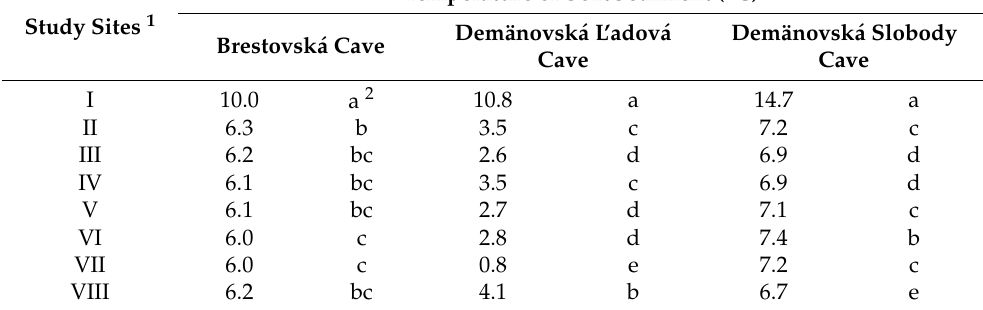
Table 1. The average of temperature of soil/sediment ( n = 9) measured in the studied Slovak caves. 1 See Figure 1 for locations (I—outside underground facilities, II–VIII—inside underground facilities). 2 Letters refer to the Tukey’s HSD test ( α ≤ 0.05) and different letters indicate